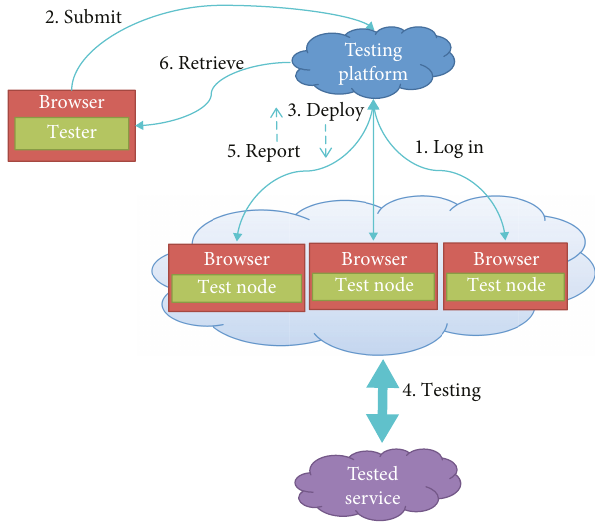
Figure 1: Conceptual architecture of